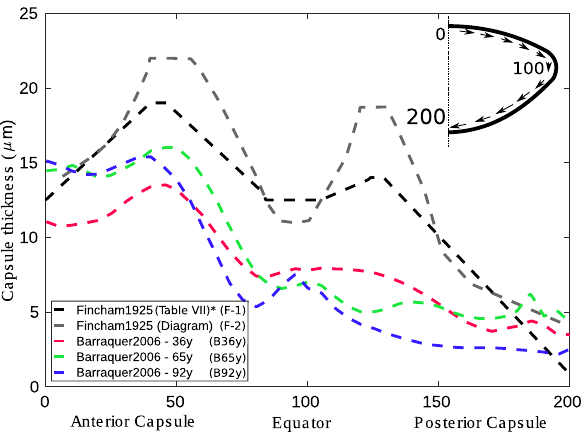
Figure 3. Five different cases of capsule thickness distribution ( µ m ) as a function of the standardised capsule perimeter. An outline for understanding standardisation is attached. *The mean values were obtained with the first and third row data from Table VII—thickness of lens capsule from Fincham 26 . The second row data of this table were discarded due to notable differences with the other data.